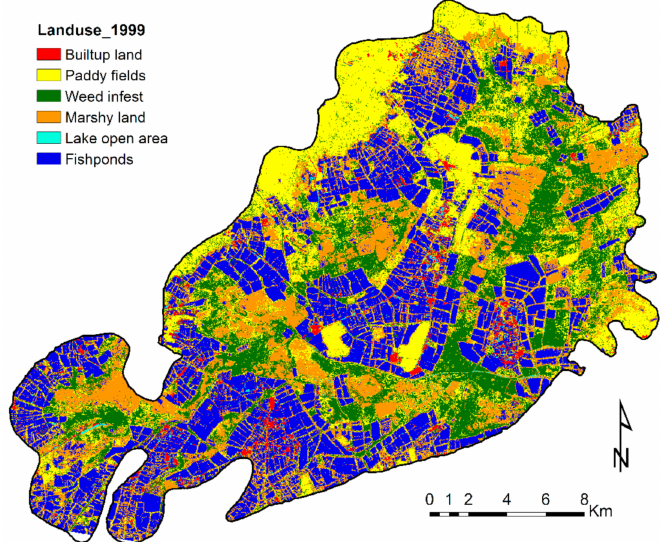
Figure 5. The 1999 land-use map of the Kolleru Lake wetland based on supervised